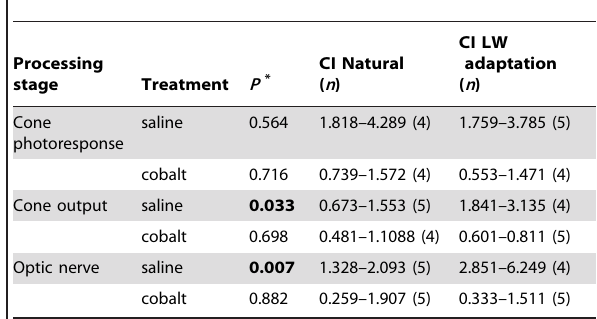
Table 1. Statistics of the effect of background illumination on the ratio between long-wavelength and ultraviolet sensitivity, across retinal processing